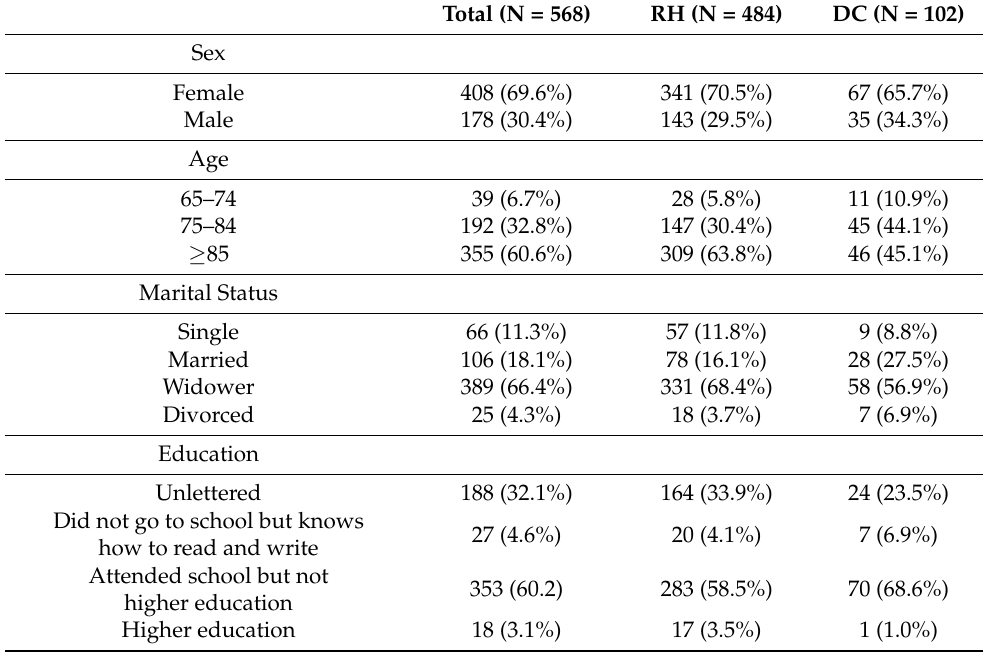
Table 1. Characterization of the sample (N =